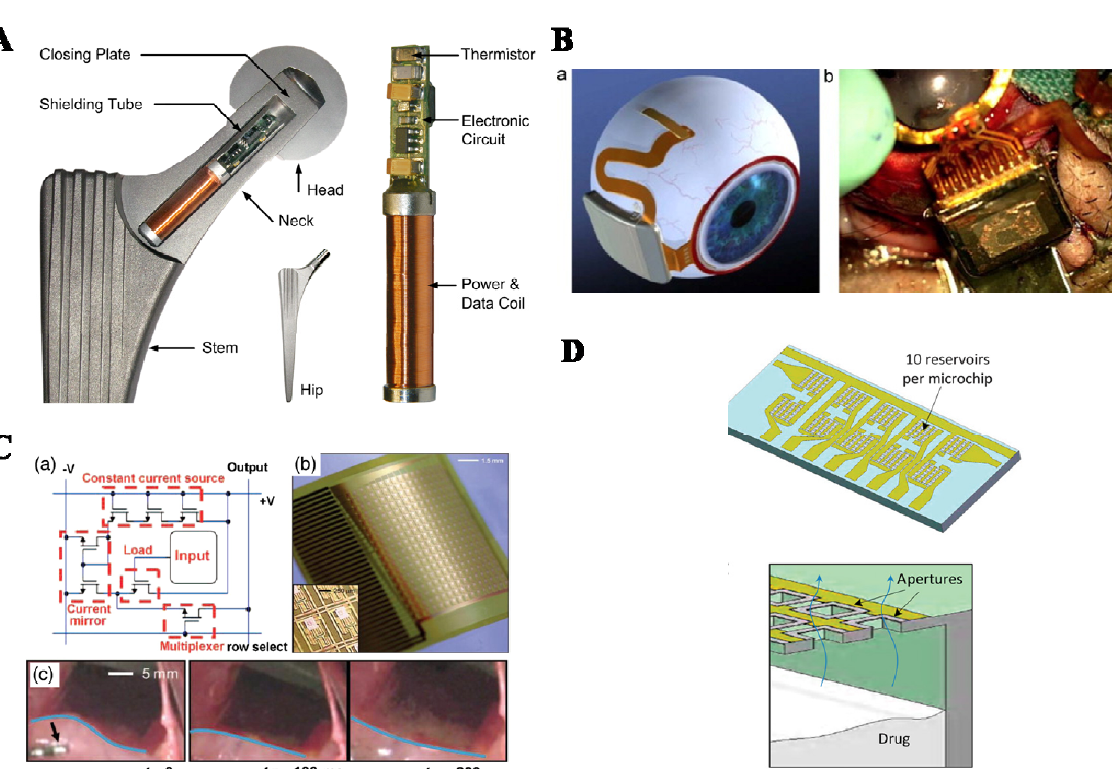
implantable microchip-based human parathyroid hormone drug delivery device (54 mm × 31 mm × 11 mm, l × w × h ) containing two microchips with 10 reservoirs each (13.0 mm × 5.4 mm × 0.5 mm, l × w × h ). Schematic cross section of microchip assembly showing drug releasing from one reservoir